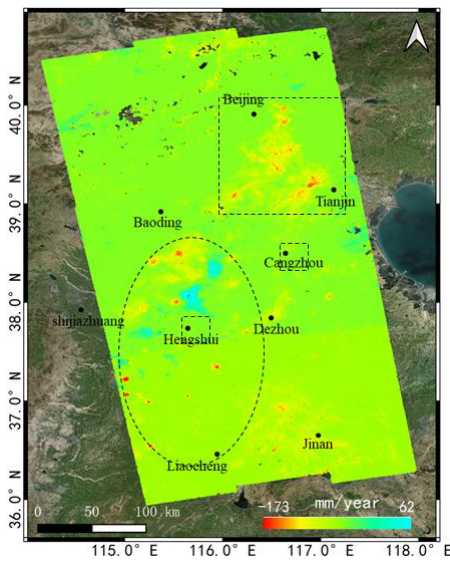
Figure 10. The mean LOS velocity (mm / year) for the North China plain with descending track 142,